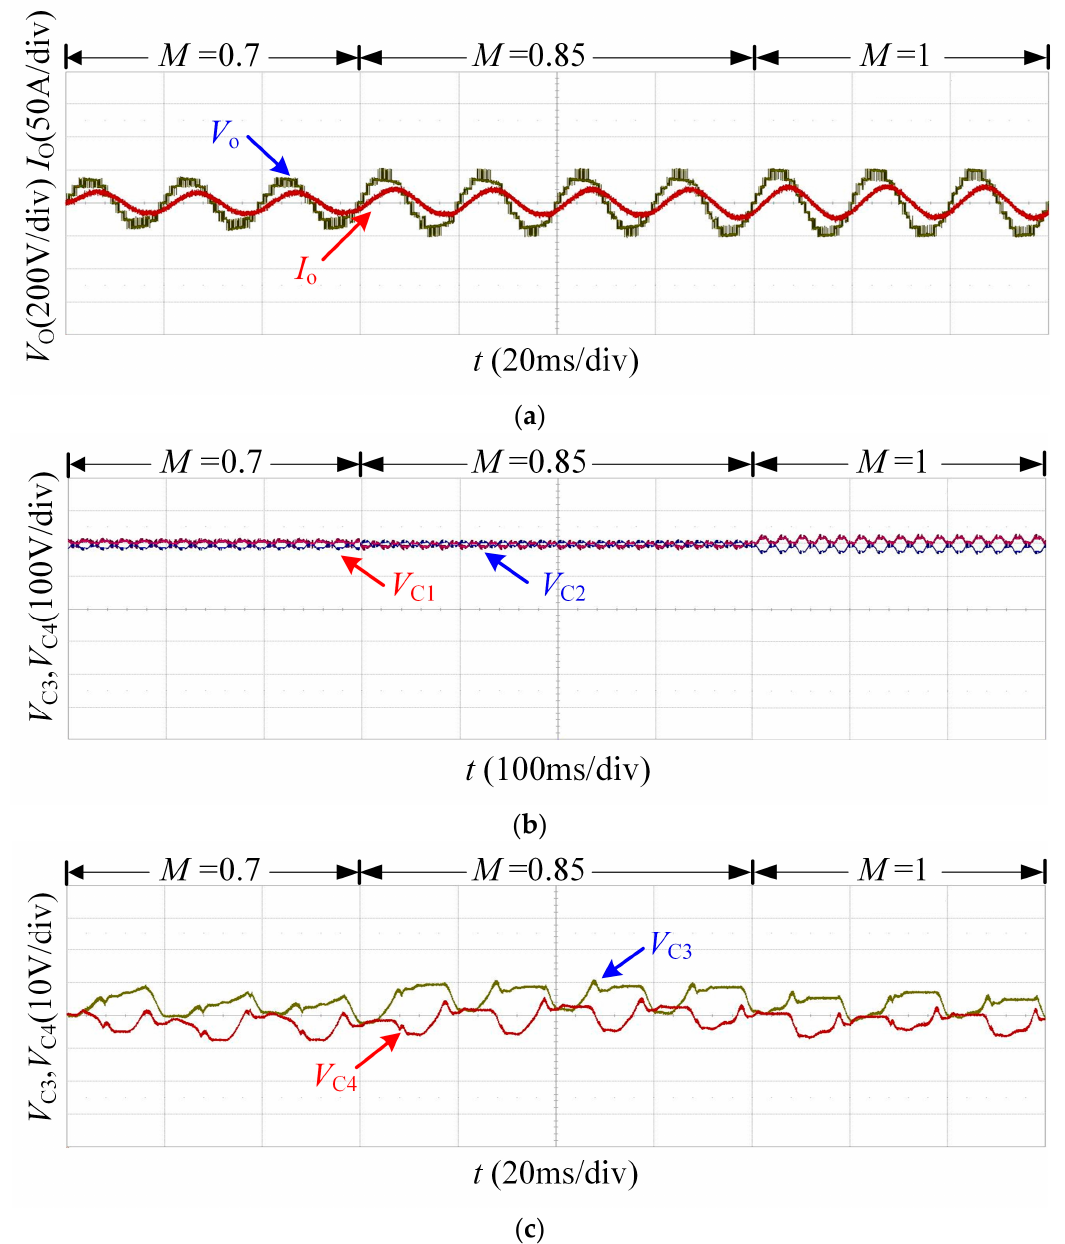
Figure 14. Experimental results of the floating capacitor voltage sensorless control scheme. ( a ) Waveforms of the output voltage V O and output current I O ; ( b ) Waveforms of the dc-link capacitor voltages V C1 , V C2 ; ( c ) Waveforms of the capacitor voltage V C3 , V C4 .